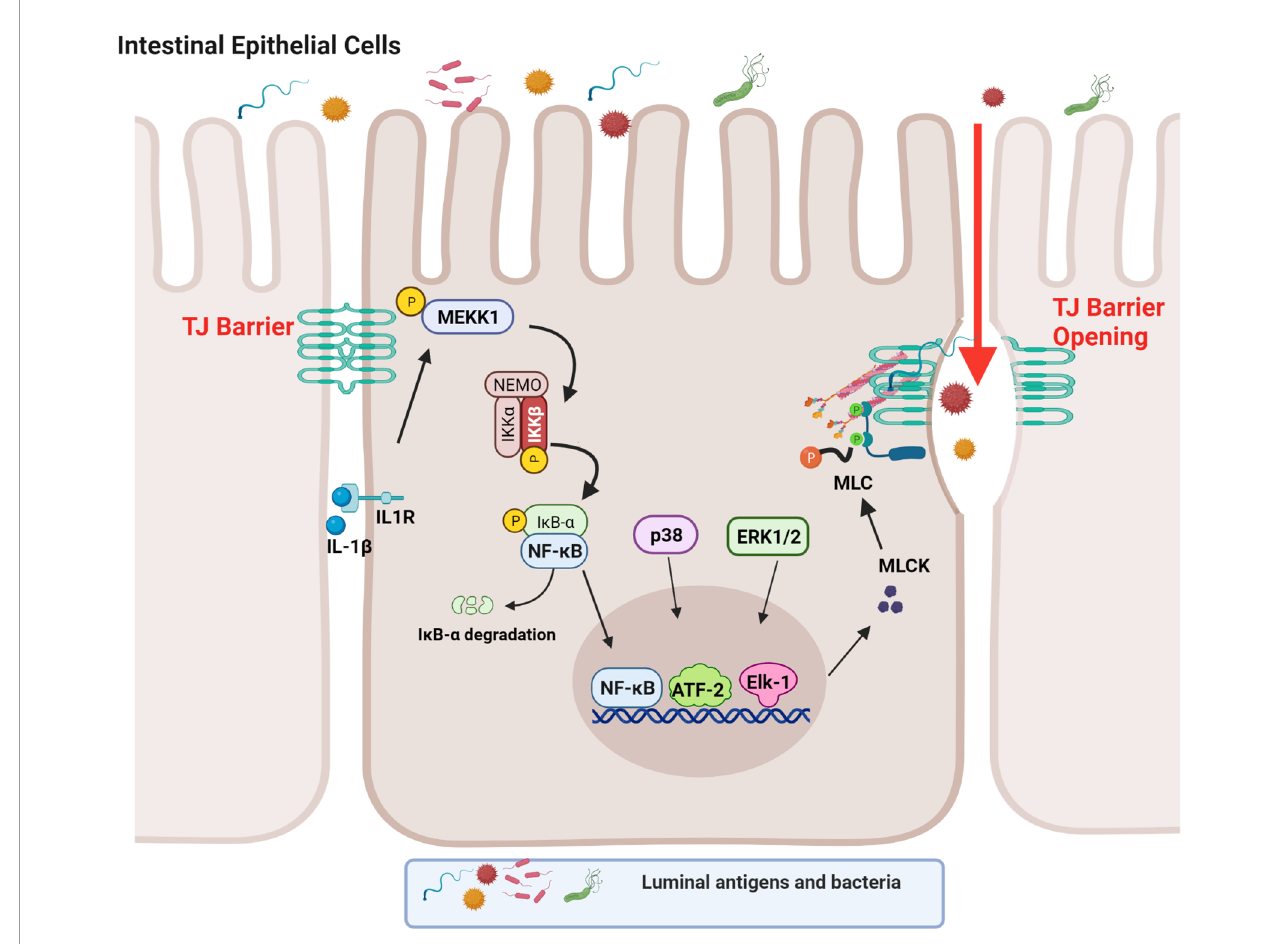
FIGURE 1 | Schematic diagram depicting the involvement of MEKK-1, IKK- b , p38 kinase, ERK1/2, and NF- k B in the interleukin-1 b (IL-1 b )-induced increase in myosin light chain kinase (MLCK) gene activity in intestinal epithelial tight junction (TJ) permeability. (Created with